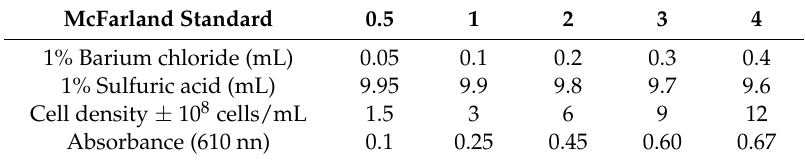
Table 1. McFarland standard values used as a reference to adjust the turbidity of yeast suspensions. McFarland